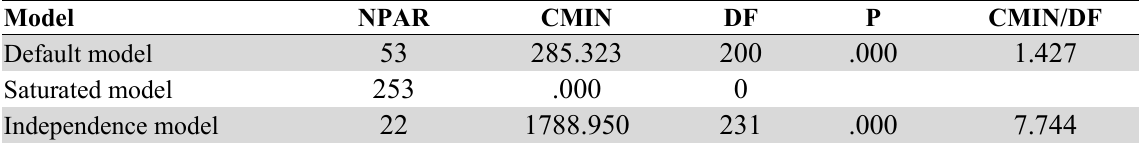
Chi-Square Value and DF for Constrained Model (Female Group)